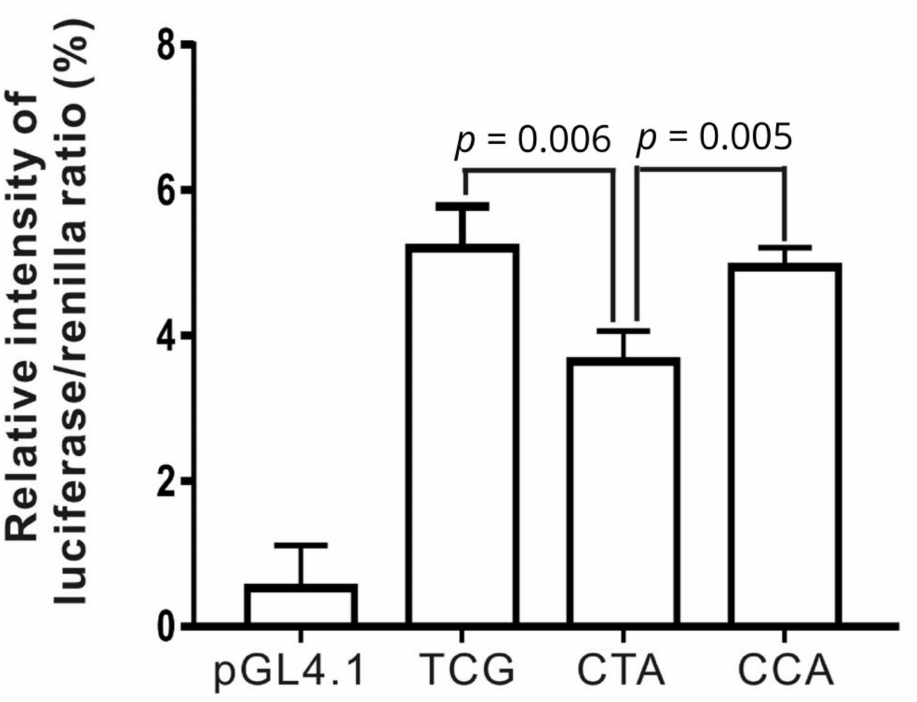
Figure 2. Luciferase reporter assay of pGL4.10-CCA, CTA and TCG in HepG2 cells. Activity of LIPC haplotype H2: CTA significantly decreased 30% and 26.3% as compared with H1: TCG and H3: CCA, respectively. Data were normalized to renilla activity and expressed as percentage of PGL